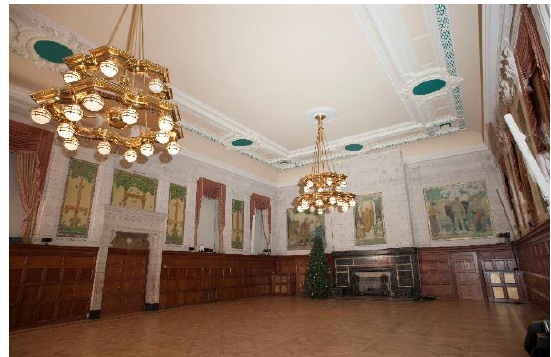
Figure 5: Former House of Commons Reading Room (HCS,